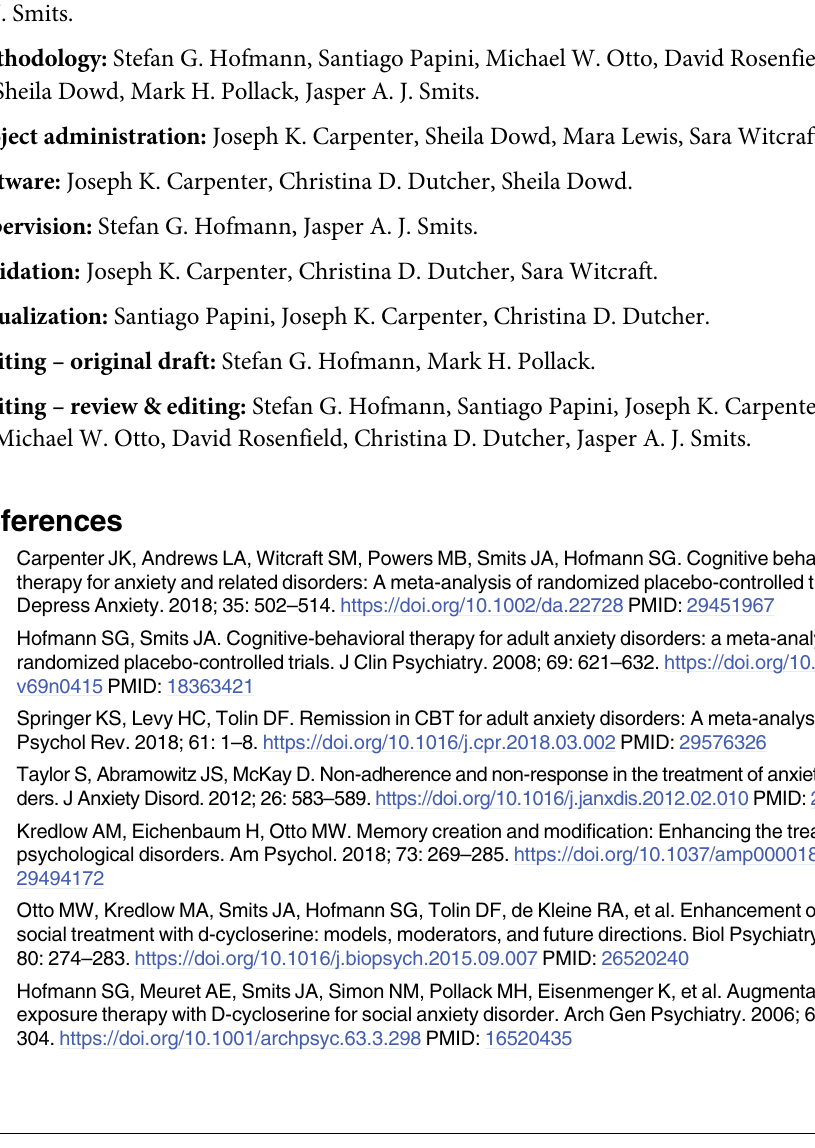
S2 File. Supplementary analyses. Sensitivity analyses were run with all available data to deter- mine whether exclusion of non-conditioners affected the impact of DCS vs. PBO on extinction retention. Consistent with results when analyzing only conditioners, no main or interactive effects of group were seen during recall or renewal phases for SCR or US expectancy